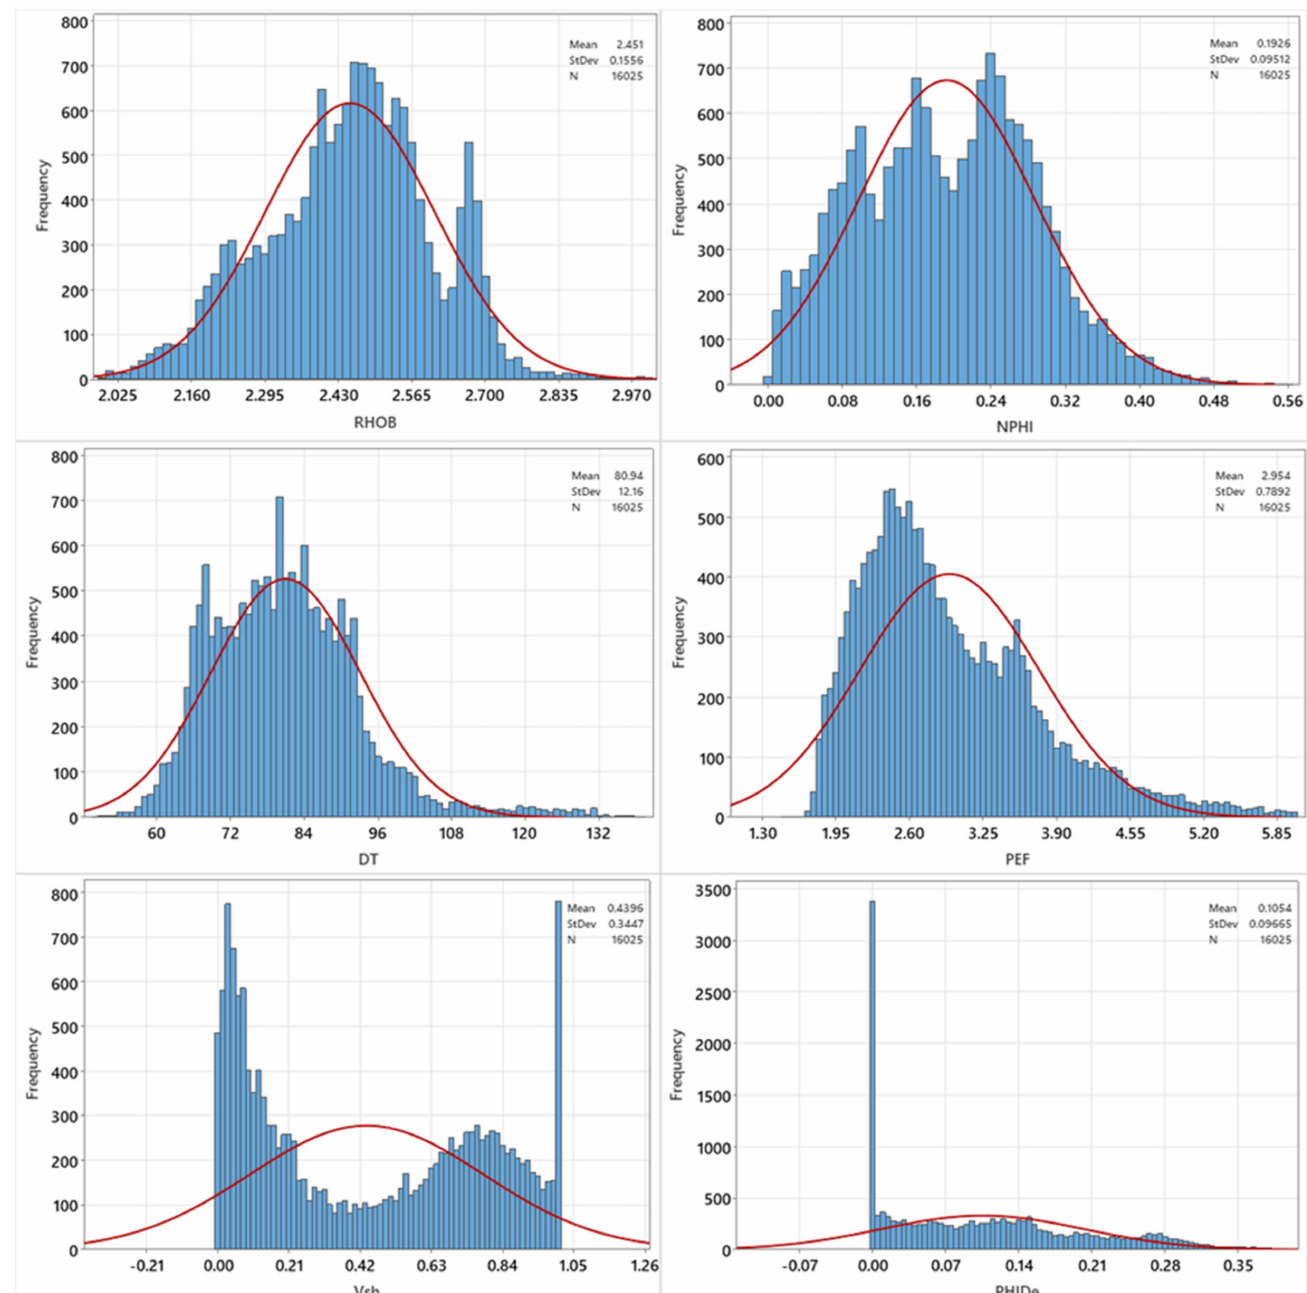
Figure 2. Variations of the major MRA